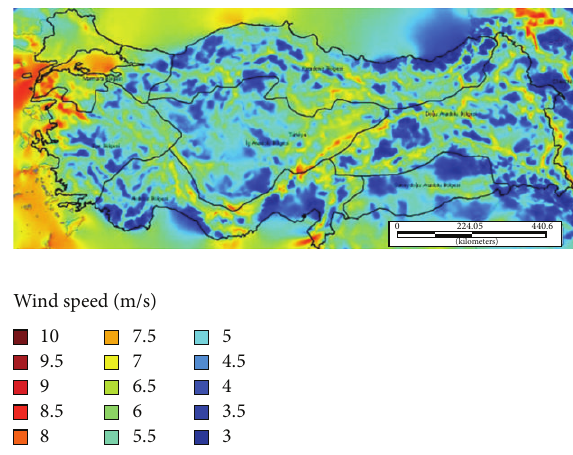
Figure 5: Scattering of average wind speed at 50 m high in Turkey.